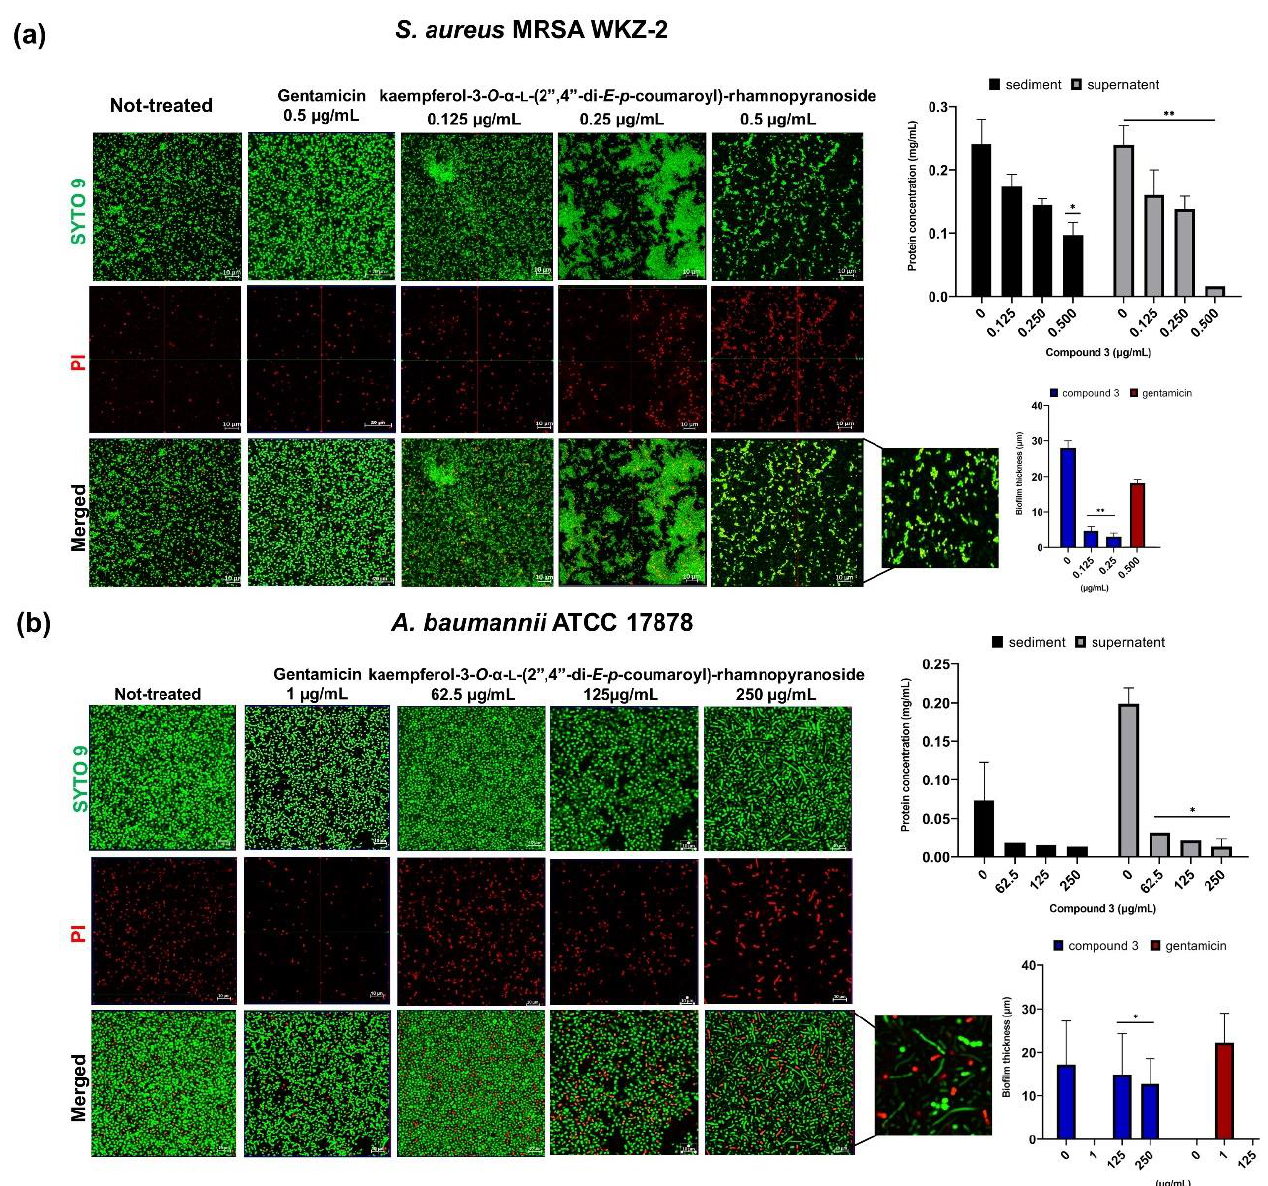
Figure 7. Antibiofilm activity of purified kaempferol-3- O - α - L - (2″,4″ -di- E-p